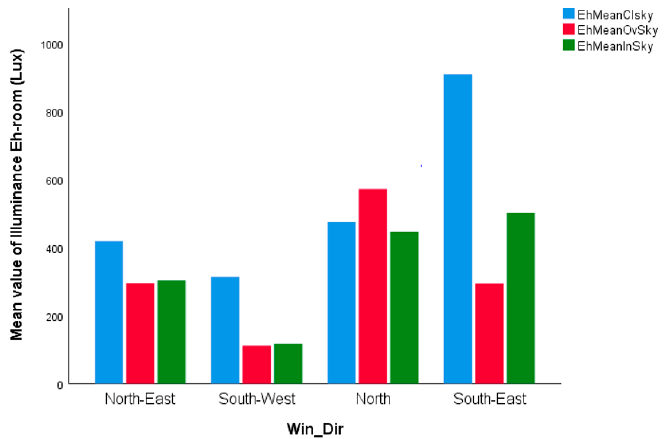
Figure 5. ( a ) DGP values under clear sky (blue), overcast sky (red), and intermediate sky (green) conditions: imperceptible level (DGP < 0.3), perceptible level (0.3 < DGP < 0.35), disturbing glare (0.35 < DGP < 0.4), intolerable glare (DGP > 0.45); ( b ) The details of the mean values under clear sky condition.